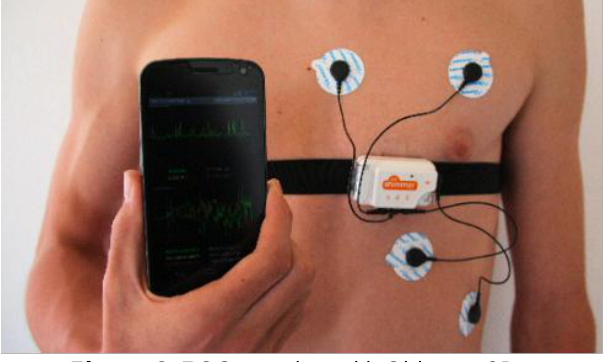
Figure 6. ECG sensing with